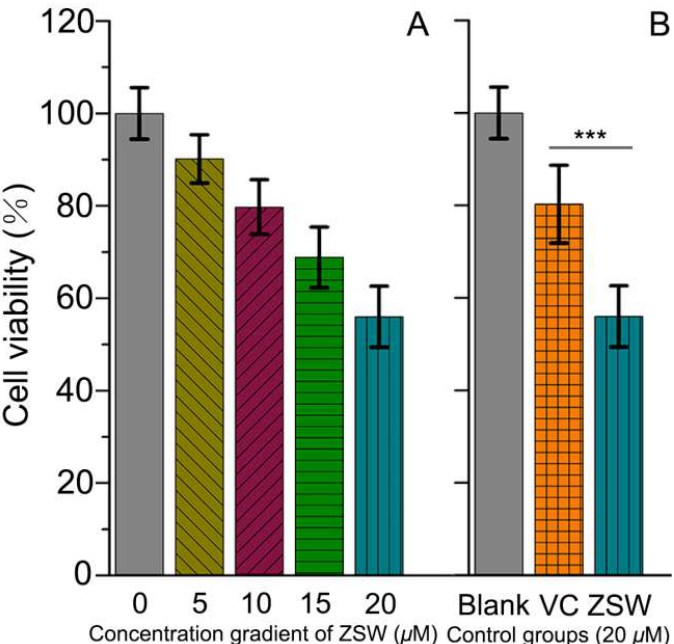
Figure 7. PC12 cell viability determined by MTT assay ( A ) after incubated by ZSW of different concentration gradients (0, 5, 10, 15, 20 μM). ( B ) Incubation by different control groups (Ctrl: blank group; VC: 20 μM ZSW + 20 μM ascorbic acid; ZSW: 20 μM ZSW). (1 μM refers to 10 –6 mol · L –1 ). The results are obtained from three independent experiments and presented as the mean ± standard deviation of the independent experiments. The results were compared using a two way ANOVA (*** p ≤ 0.001).